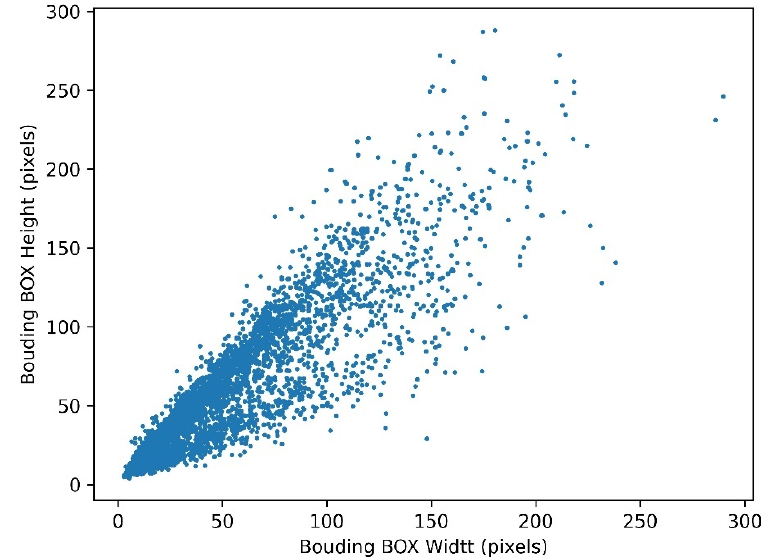
Figure 3. Objects size distribution of the vehicle taillight dataset.